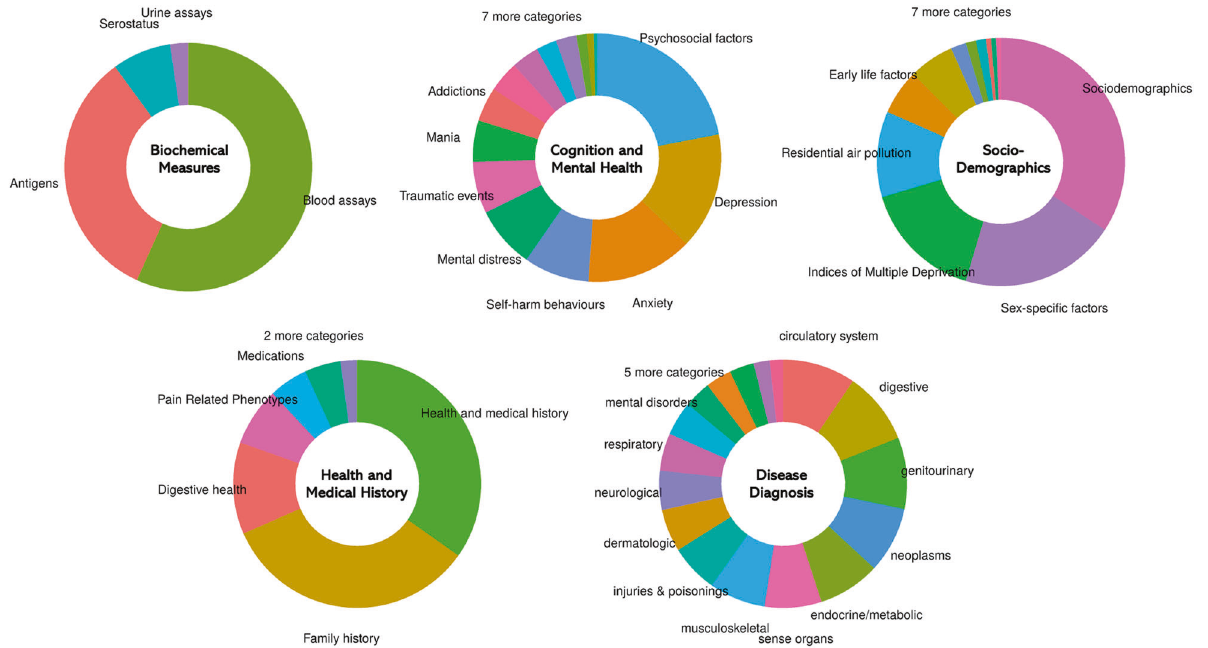
Fig. 1 Overview of the phenotypic categories in UK Biobank. The size of pie chart sections indicating the number of included outcomes: biochemical measures (167), cognition and mental health (223), disease diagnosis (1430), health and medical history (270) and sociodemographics (152).